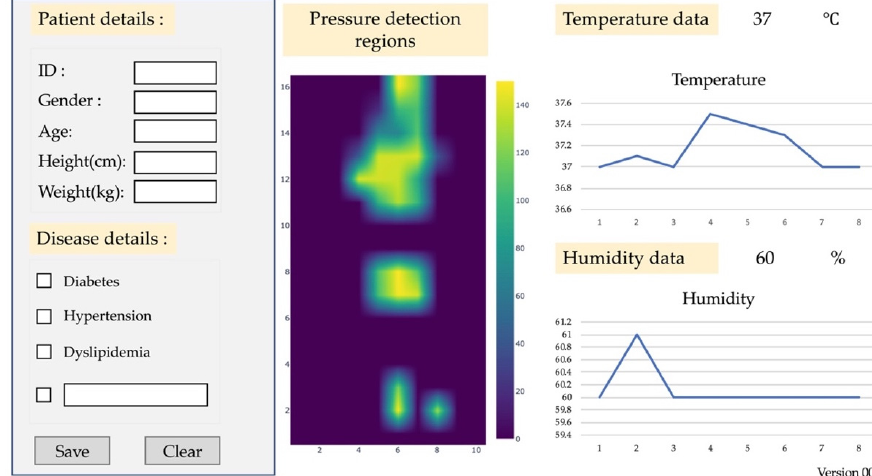
Figure 10. Mattress platform.